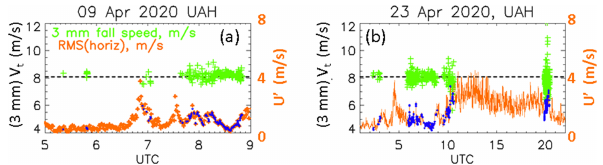
Figure 5. (a, b) RMS of horizontal wind speed from the 100Hz CSAT-3B data (in orange) and 3mm drop fall speed measurements from 2DVD:SN16 (in green) for the events on 9 April 2020 (a) and 23 April 2020 (b) . The blue points are the interpolated rms val- ues corresponding to the timestamps of the 3mm drops. The black dashed line represents the expected fall speed for the 3mm drops.